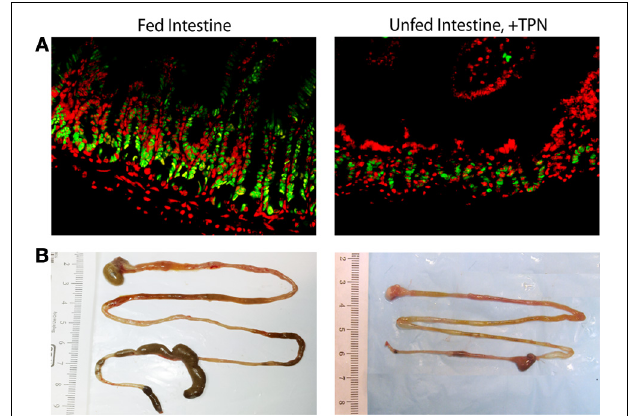
FIGURE 1 | Loss of epithelial barrier function with TPN leads to bacterial translocation and sepsis. Lymph node (LN) and spleen isolates from TPN-dependent mice were incubated on Columbia-CNA agar (A) to isolate Gram-positive bacteria. Similarly, culture on MacConkey agar demonstrates Gram-negative bacteria from TPN-dependent LN isolates (B) . Rates of bacteremia are significantly greater in TPN-dependent vs. fed mice (C) (Sun et al.,